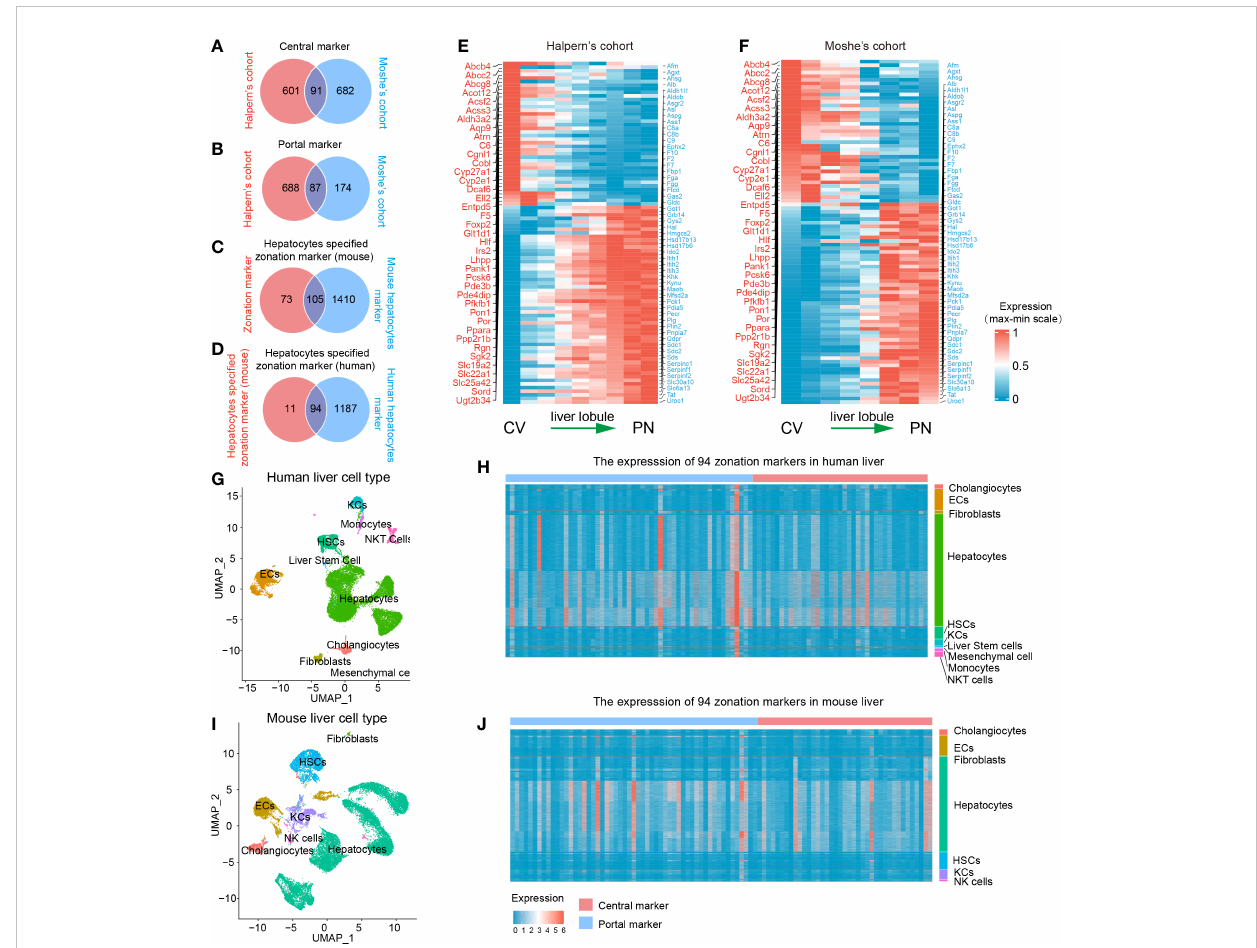
FIGURE 2 Identi fi cation of 94 human hepatocyte-speci fi ed zonation markers. Venn plots of central markers (A) , portal markers (B) , mouse hepatocyte- speci fi ed zonation markers (C) , and human hepatocyte-speci fi ed zonation markers (D) . Heatmap plots of the expression patterns of the 94 human hepatocyte-speci fi ed zonation markers in different areas of liver lobule in Halpern ’ s (E) and Moshe ’ s (F) cohorts. UMAP visualization of different cell types from human liver (25470 cells) by snRNA-seq (G) . Heatmap plot shows the expression of 94 hepatocyte-speci fi ed zonation markers in different cell types from the human liver (H) . UMAP visualization of different cell types from the mouse liver (25335 cells) by snRNA-seq (I) . Heatmap plot shows the expression of 94 hepatocyte-speci fi ed zonation markers in different cell types from mouse liver (J) . CV, Central venous; PN, Portal node; UMAP, Uniform Manifold Approximation and Projection; ECs, Endothelial cells; KCs, Kupffer cells; NK cells, Natural killer cells; HSCs, Hepatic stellate